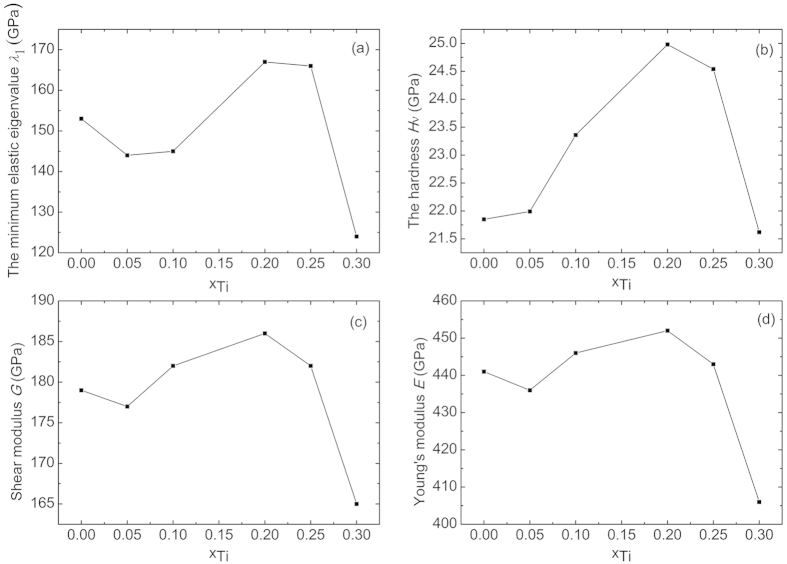
(a) The smallest elastic eigenvalue λ1, (b) hardness Hν, (c) shear modulus G and (d) Young’s modulus E of V5C3 alloys.